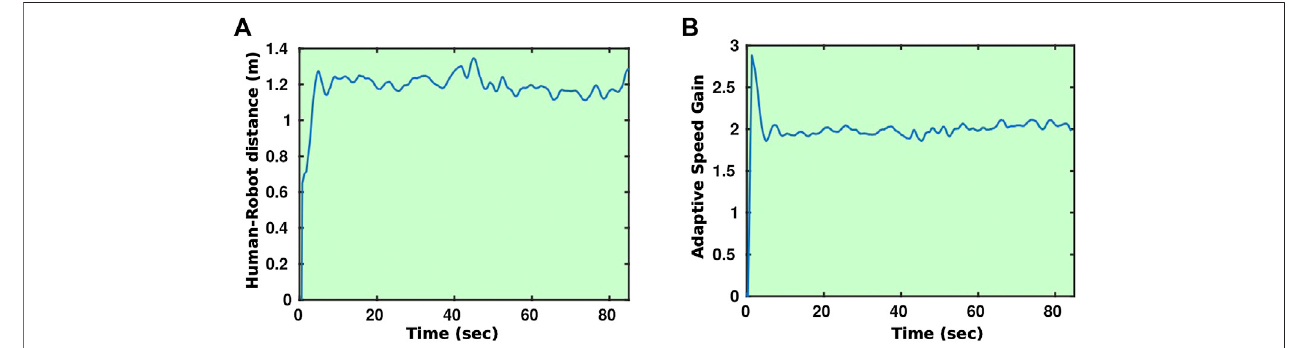
FIGURE 13 | Time evolution of the human – robot distance (A) and adaptive gain (B) during a guiding